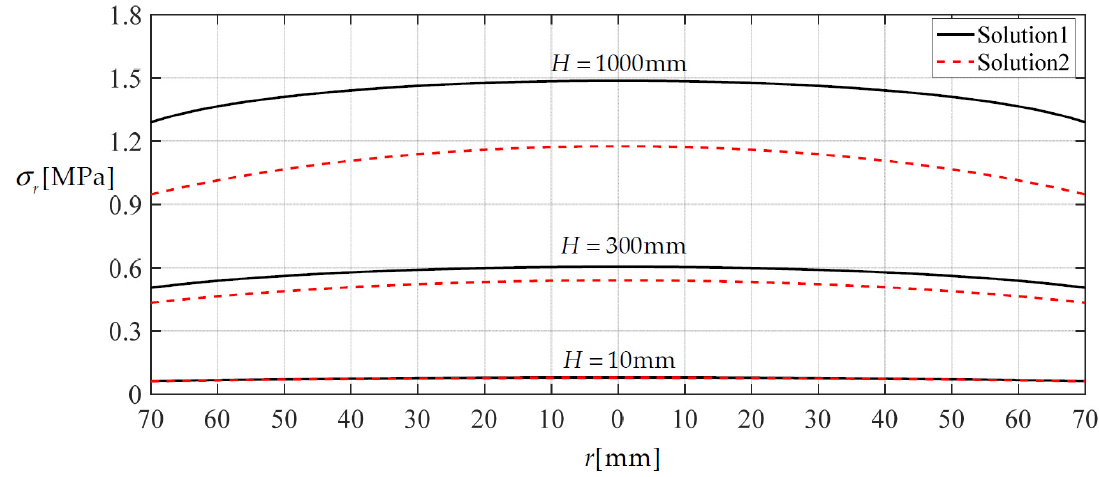
Figure 8. Variations of σ r with r when H is 10, 300 and 1000 mm,